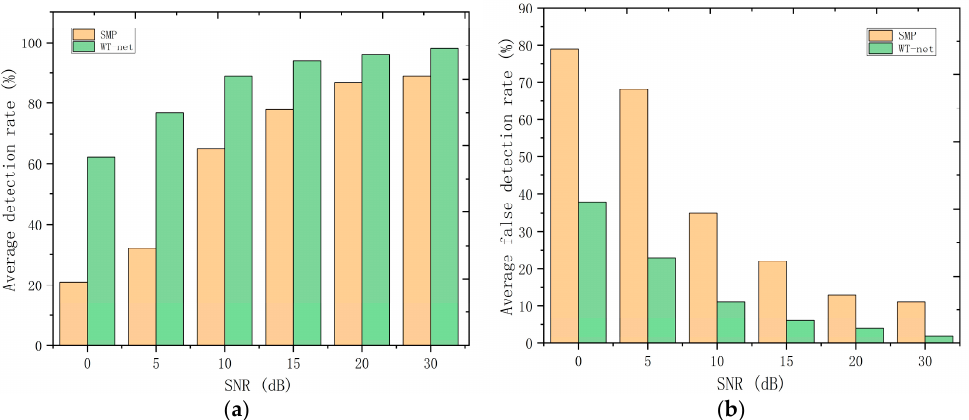
Figure 6. Performance of the methods with two single echo signals mixed under different SNRs: ( a ) average detection rate, ( b ) average false detection rate.